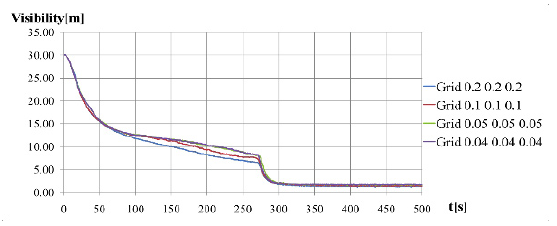
Figure 5. Average visibility in Mesh 1 for different grid